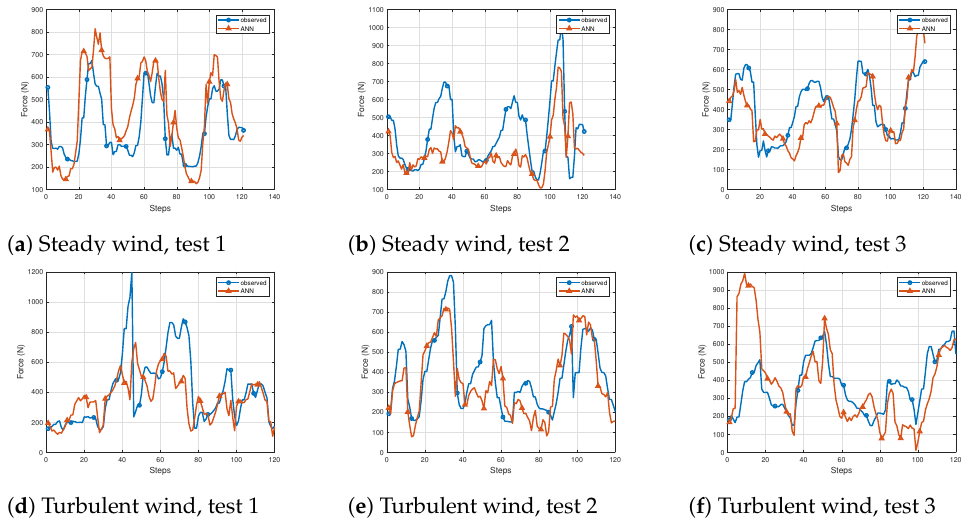
Figure 19. Experimental validation of predicted tether force from ANN: ( a – c ) test results for steady wind conditions, ( d – f ) test results for turbulent wind conditions.